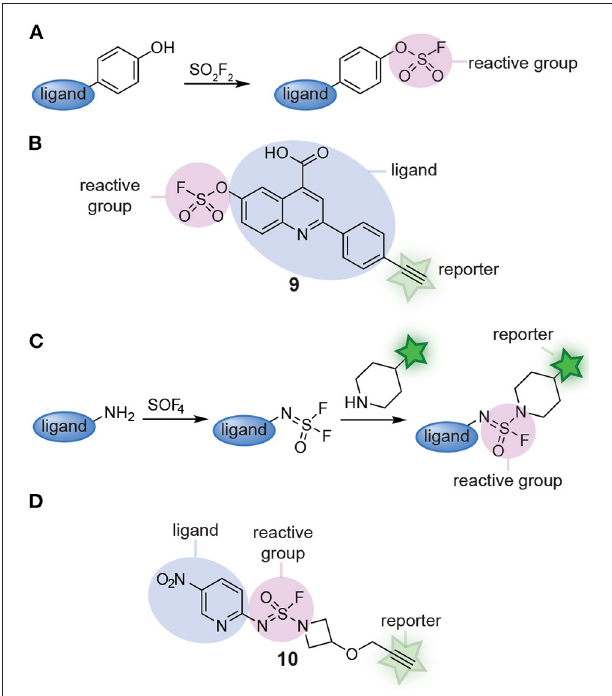
FIGURE 3 | (A) Schematic representation of fluorosulfate probe synthesis with SuFEx. (B) An example of a fluorosulfate probe ( 9 ) prepared from a phenolic compound via SuFEx chemistry. (C) Schematic representation of sulfuramidimidoyl fluoride probe synthesis with SuFEx. (D) An example of a sulfuramidimidoyl fluoride probe ( 10 ) prepared from a primary and a secondary